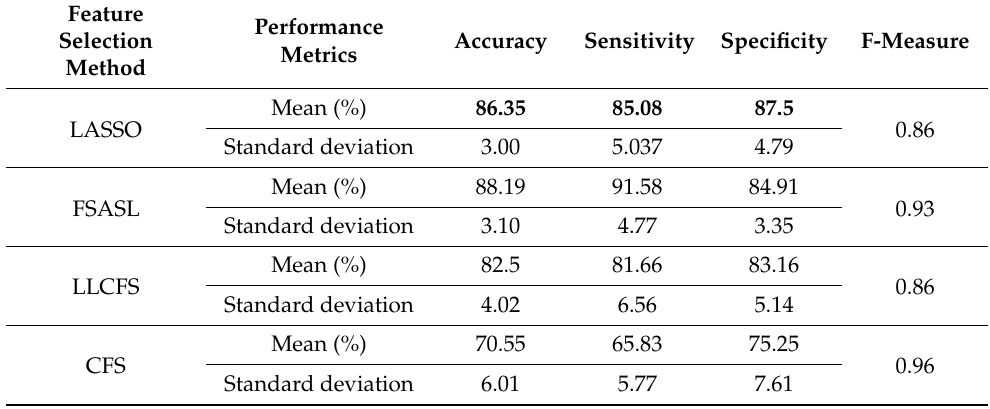
Table 10. Classification performance for HC against MCI using SL-RELM classifier Combined brain network using different feature selection